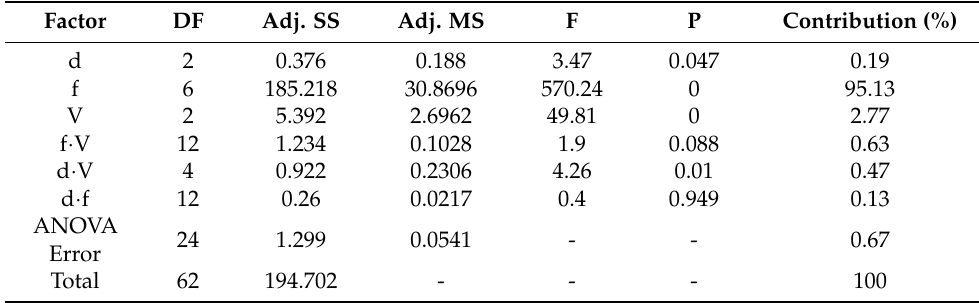
Table 4. ANOVA analysis results for arithmetic average roughness under LIL